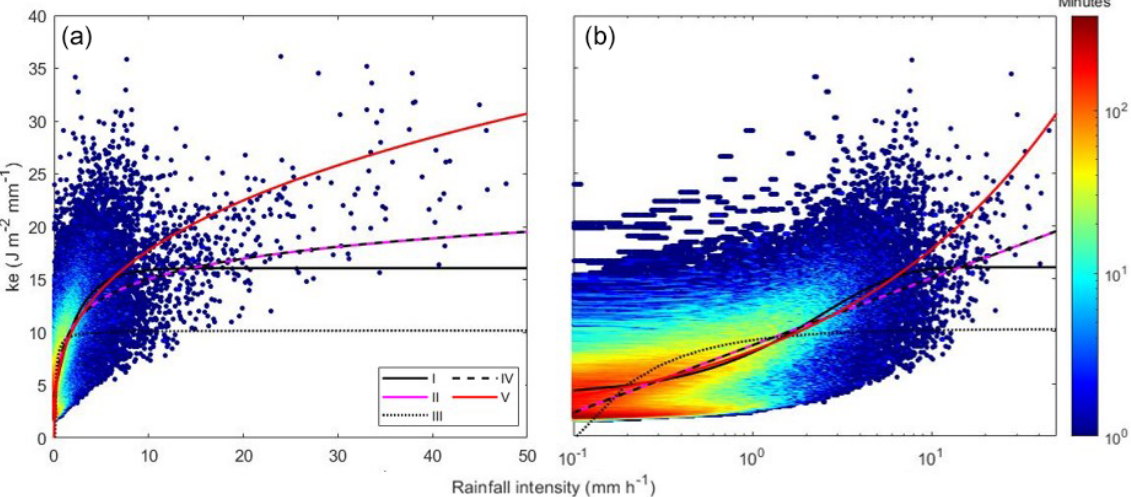
Figure 2. Number of minutes per intensity class ( x axis) and ke class ( y axis) with five fitted ke– I curves at Chilbolton station (2004–2013), plotted on linear (a) and logarithmic (b) intensity scales.